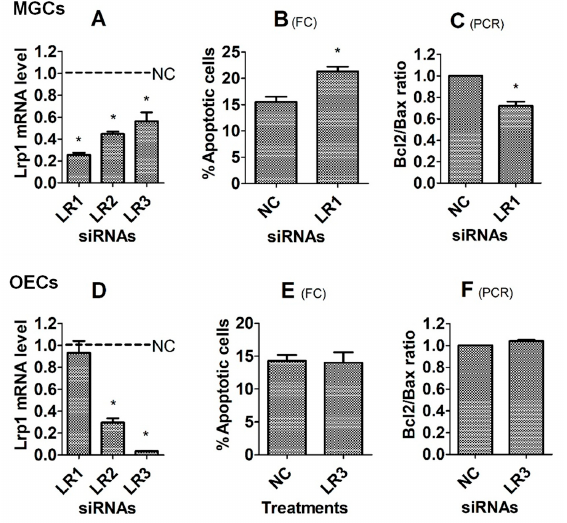
Figure 5. Effects of knocking down Lrp1 on corticosterone-induced apoptosis of MGCs and OECs. Graphs ( A , D ), ( B , E ) and ( C , F ) show Lrp1 mRNA level, percentage of apoptotic cells, and the ratio of Bcl2/Bax mRNA, respectively, after MGCs or OECs were transfected with negative control (NC), Lrp1 siRNA-1 (LR1), -2 (LR2) or -3 (LR3). While the mRNA level was revealed by RT-PCR, the per- centage of apoptotic cells was measured by flow cytometry (FC). Each treatment was repeated 3 times with each replicate including cells from 2 wells of a 6-well plate from 12 mice (MGCs) or from 4 mice (OECs). * Indicates significant difference ( p < 0.05) from NC cells. In graphs ( B ) and ( E ), the percentages of apoptotic cells included both early and late apoptotic cells. In graphs ( C ) and ( F ), the ratio of Bcl2/Bax mRNA in NC cells was set to one and that in LR1 or LR3 cells was expressed rela- tive to it.